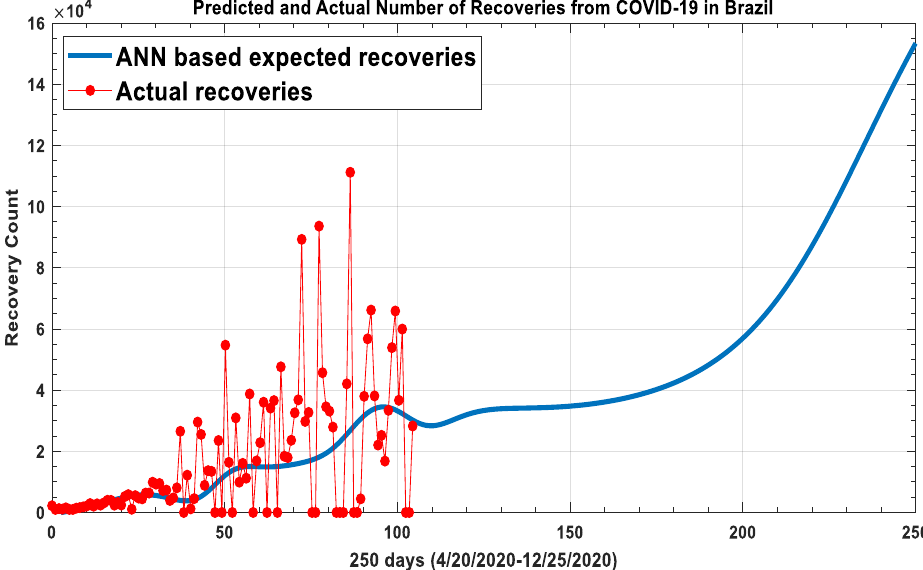
Figure 4. The training data and predicted data of COVID-19 recovered people in Brazil.